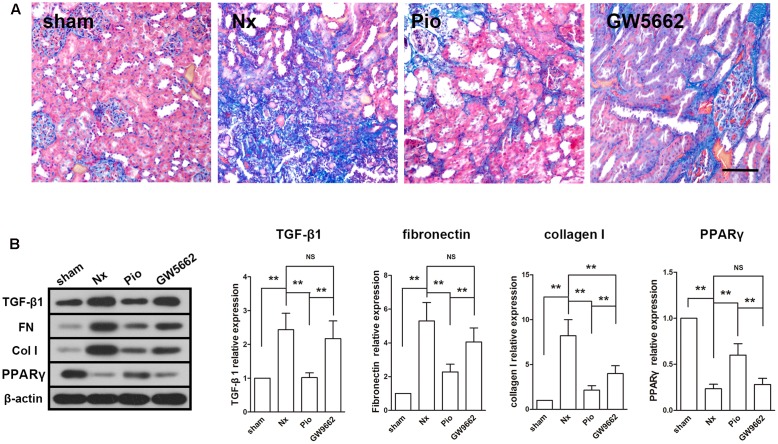
Effects of pioglitazone on renal fibrosis and profibrotic proteins in the kidney of Nx rats. (A) Masson’s staining showed large fibrotic area in the kidney of Nx rats and pioglitazone significantly reduced the fibrotic area. Scale bar: 100 μm. (B) The increased expressions of profibrotic proteins TGF-β1, fibronectin and collagen I in the kidney of Nx rats were markedly decreased after pioglitazone treatment. These effects were at least partly PPARγ dependent. n = 6. ∗P < 0.05, ∗∗P < 0.01.